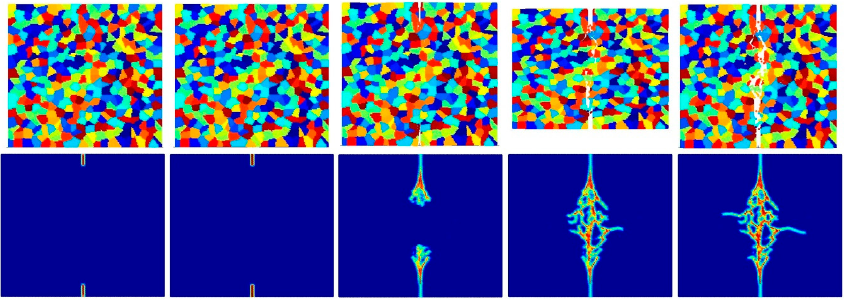
Figure 28. Fracture pattern of polycrystal when β = 1.0 with 400 grains in total. From left to right: time = 1.5 µ s, 2.0 µ s, 2.5 µ s, 3.0 µ s, and 3.5 µ s, respectively.